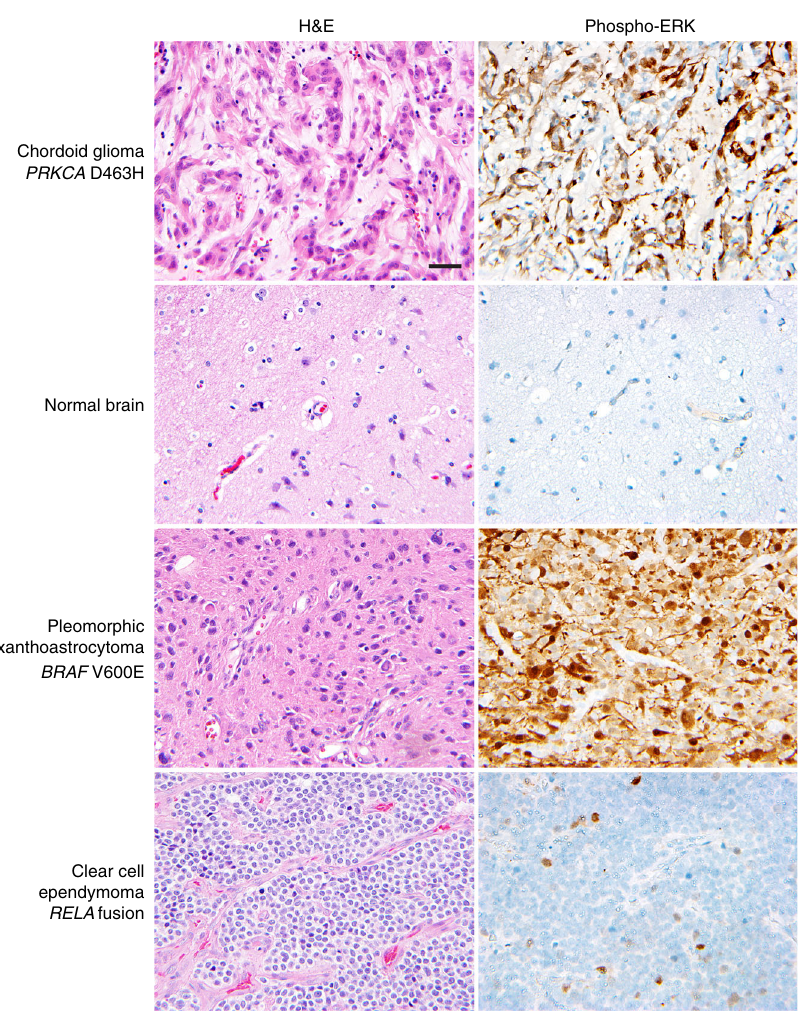
Fig. 3 Chordoid gliomas demonstrate high levels of phospho-ERK, equivalent to levels seen in other glioma types harboring oncogenic alleles of Ras-Raf- MAP kinase pathway components. Shown are representative images of hematoxylin and eosin (H&E) staining and phospho-ERK immunohistochemistry on a chordoid glioma with PRKCA D463H mutation (CG-UVA-1), normal brain, pleomorphic xanthoastrocytoma with BRAF V600E mutation, and clear cell ependymoma with C11orf95 - RELA gene fusion. Scale bar, 40 μ m